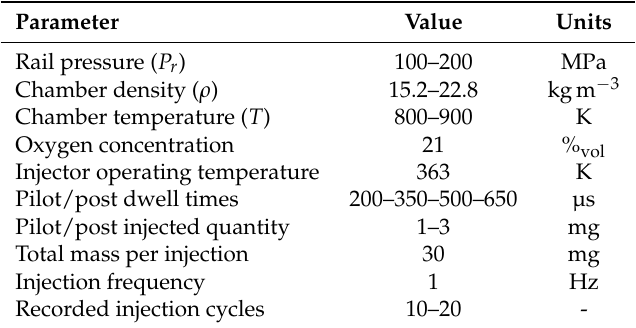
Table 2. Test plan for the reactive spray visualization